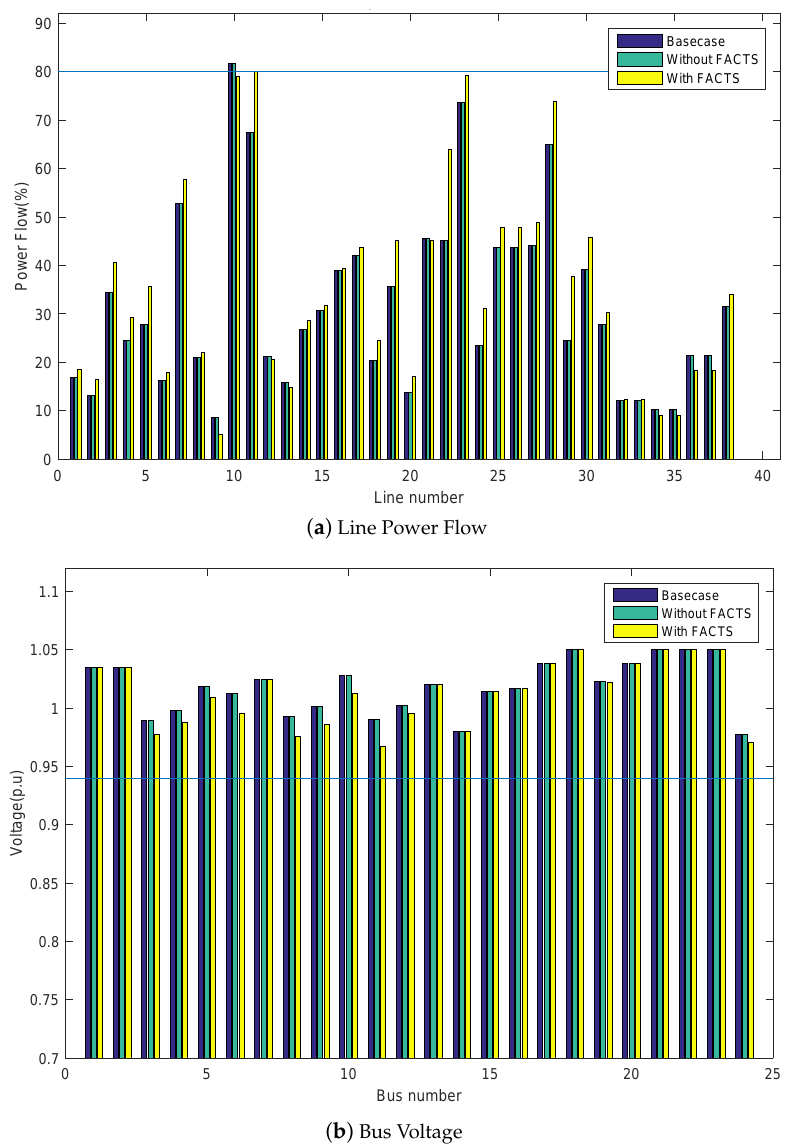
Figure 3. Line power flow and bus voltage of IEEE 24 bus